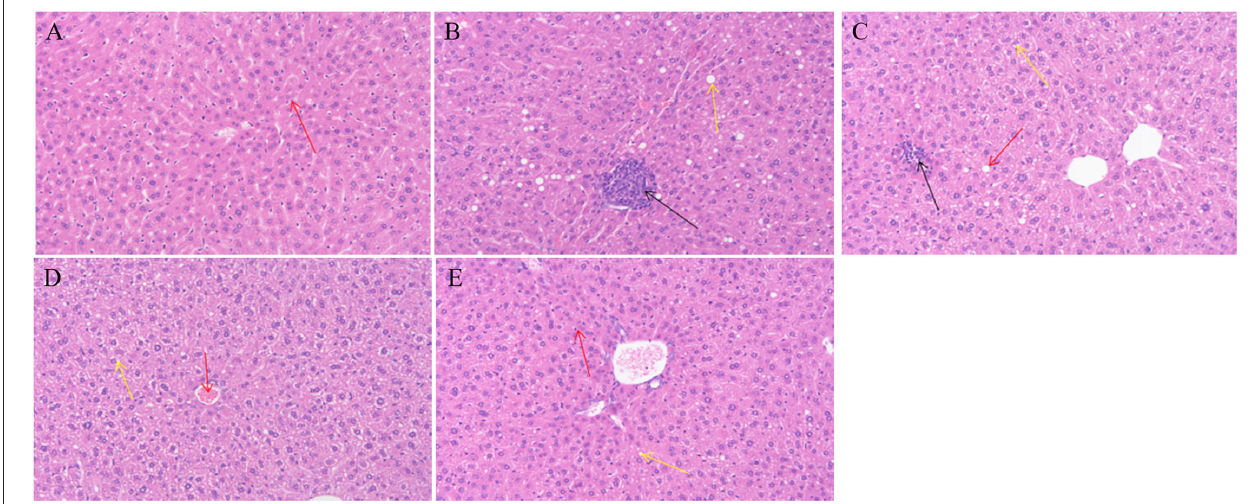
FIGURE 6 | Effects of different doses of GMP on liver tissue of mice. (A) Normal group. (B) T2DM model group. (C) GMPL group. (D) GMPM group. (E) GMPH group. Magnification: (A–E) × 100. GMP, germinated mung bean polyphenol; T2DM, type 2 diabetes mellitus; GMPL, low dose intervention group; GMPM, medium dose intervention group; GMPH, high dose intervention